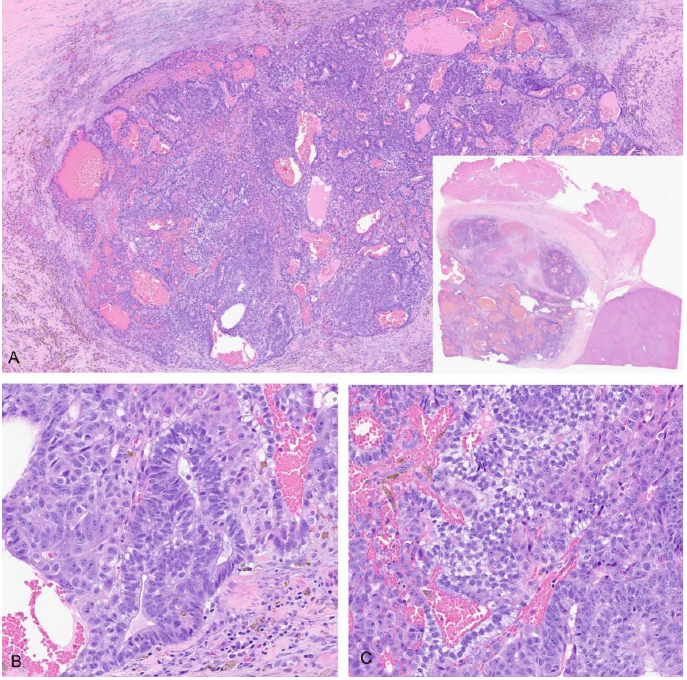
Figure 4. Extrahepatic tumor with teratoid elements, THB23. ( A ) H&E 4x; whole slide image (inset); ( B ) primitive neuroepithelium 20x; ( C ) primitive glands with subnuclear vacuoles 20x.